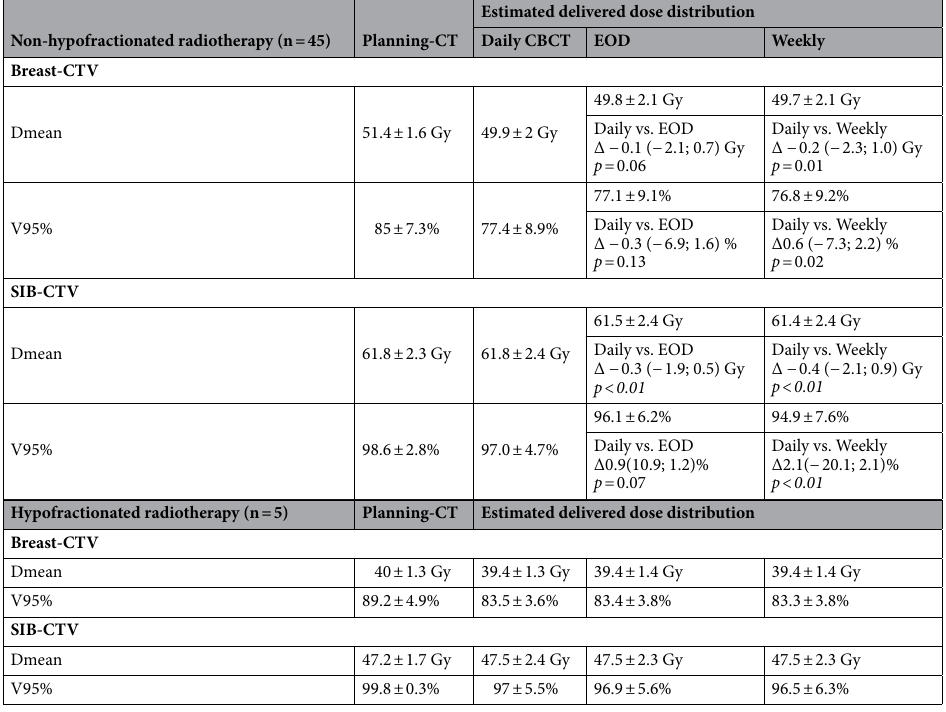
Table 2. Dose coverage of the breast-CTV and SIB-CTV and the in the planning CT compared and the estimated delivered dose distribution. Mean values and standard deviation. Mean absolute differences between CBCT-protocols